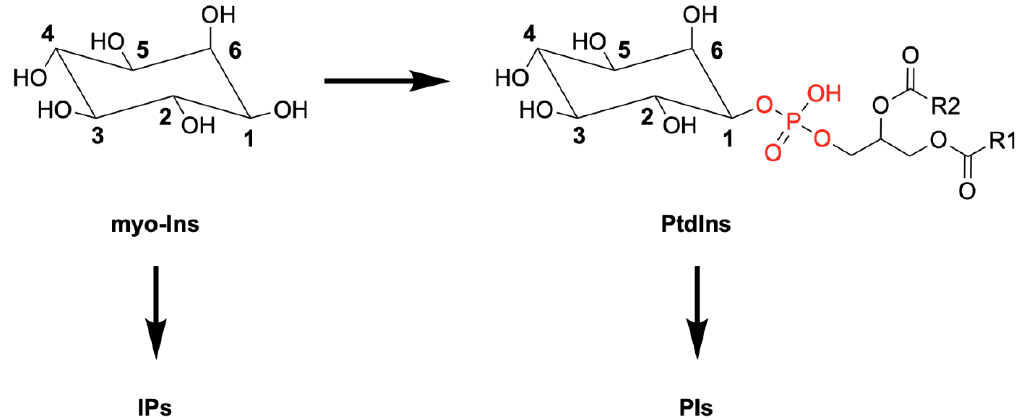
Figure 1. Schematic representation of myo -inositol (Ins) and its derivative phosphatidylinositol (PtdIns), showing the attached diacylglycerol linked to the myo -Ins head group via a phosphodiester bond (in red). Differential phosphorylation of myo -Ins or PtdIns generates the family of inositol polyphosphates (IPs) and phosphoinositides (PIs), respectively.